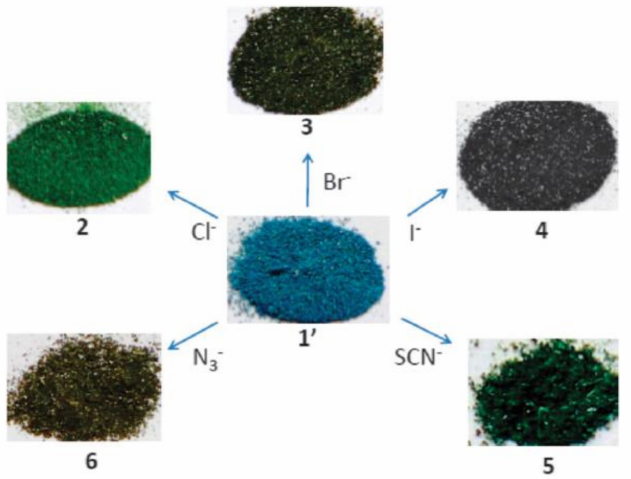
Figure 4. Color change of [CuL 2 (H 2 O) 0 . 5 ](NO 3 ) 2 ( 1 (cid:48) ) upon exchange of nitrates by the indicated anions. Chem. Commun. 2012, 48, 2946–2948 ([139])—Reproduced by permission from The Royal Society of